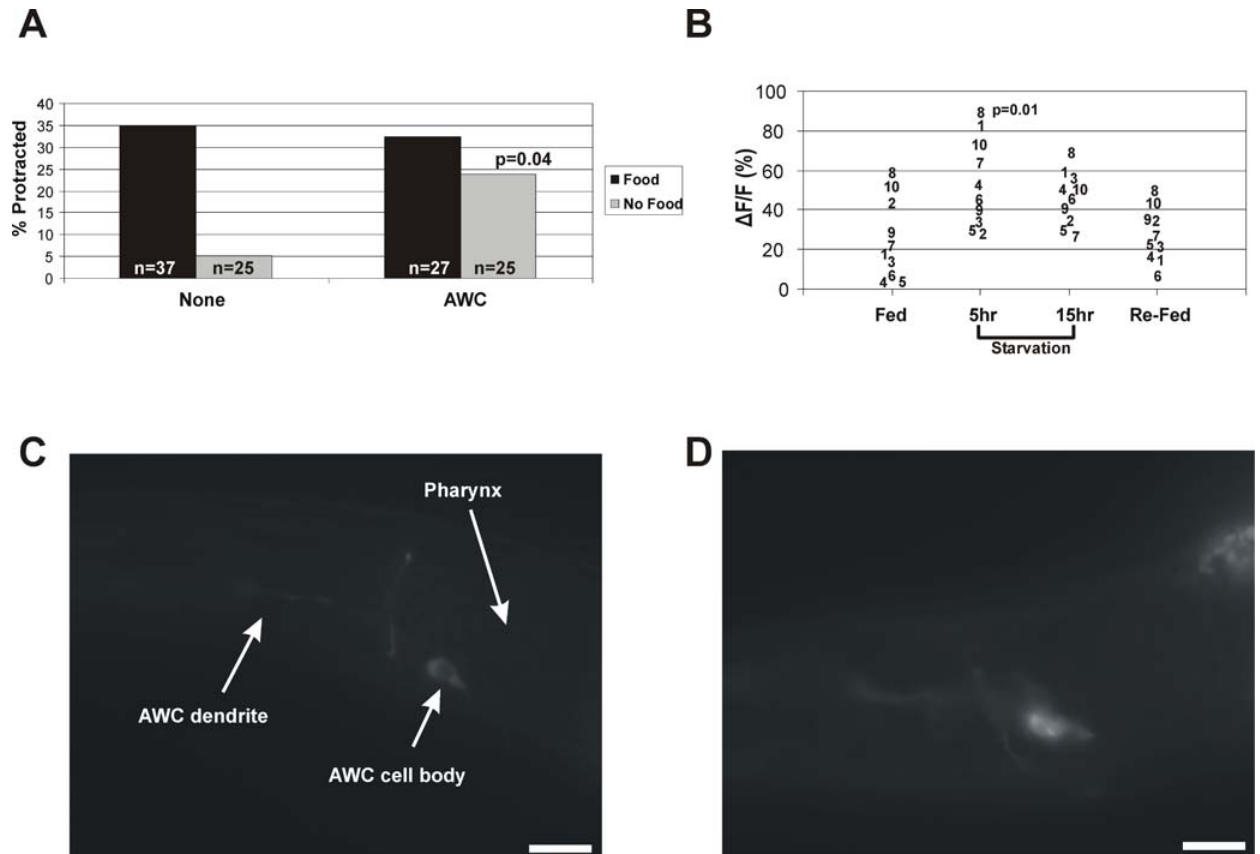
Figure 3. The olfactory AWC neurons regulate sex-muscle excitability in response to environmental conditions. (A) Graph showing the effect of laser ablation of the AWC olfactory neurons. The * denotes a significant difference (Fisher’s exact test) compared to mock ablated no-food control. (B) G-CaMP intensity changes in the left AWC neurons of 10 individual males taken after fed, 5hr and 15hr of food deprivation, and re-fed. Each number (1–10) identifies the same male for each interval. The p-value listed signifies a significant difference between Fed and 5-hr food- deprived males. (C) A representative G-CaMP intensity image of a well-fed and (D) 15hr food-deprived male (scale bar 9 m m).